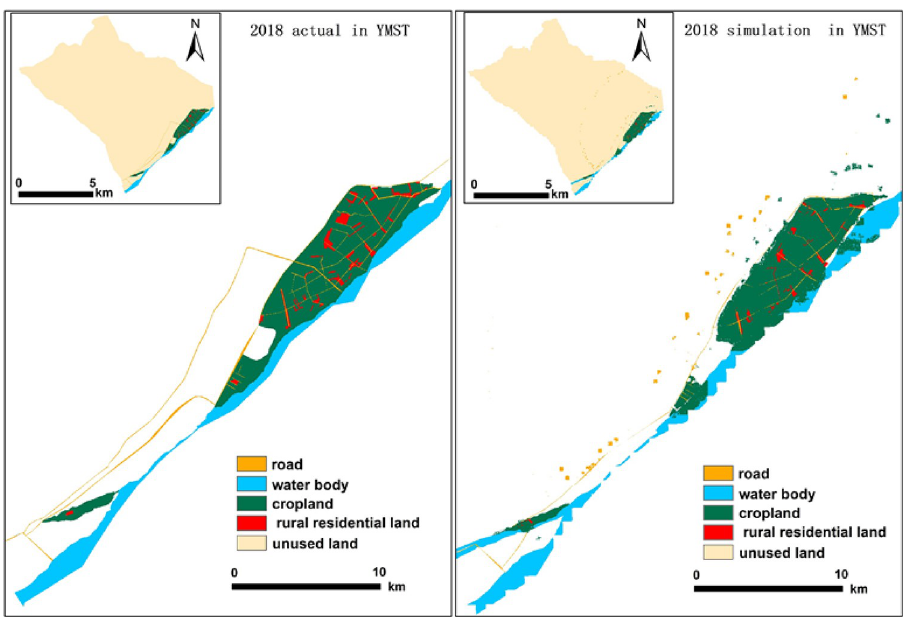
Fig 8. Actual land use in 2018 and simulated land use in 2018 obtained by PLUS of YMST. (Software: ArcMap 10.2.0, http://www.esri.com).